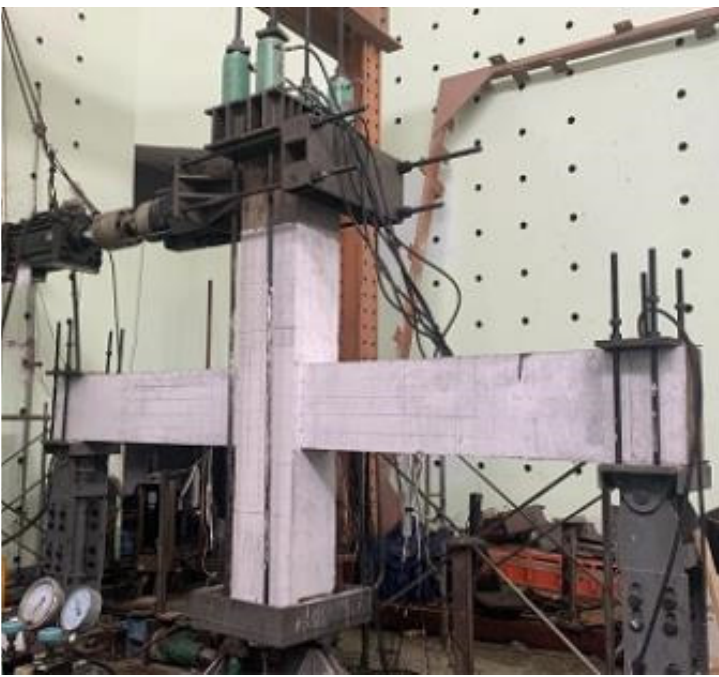
Figure 8. The loading device (unit: mm).